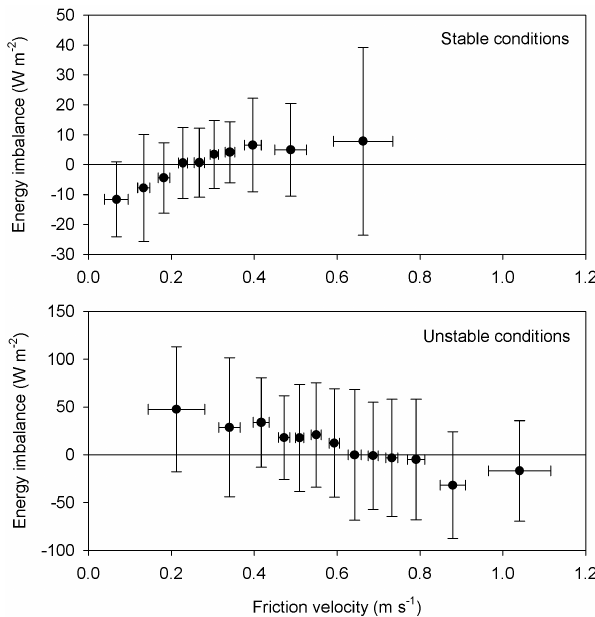
Fig. 11. Binned averages of energy imbalance including storage versus friction velocity during night (top) and day (bottom), respec- tively. Notice the difference in